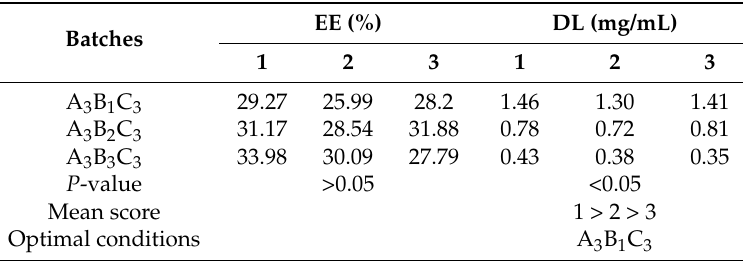
Table 4. Selection and verification of optimized parameters.